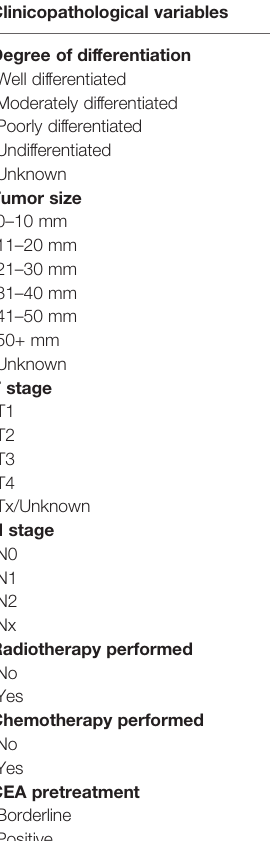
TABLE 7 | Score of every clinicopathological variable in our nomogram.